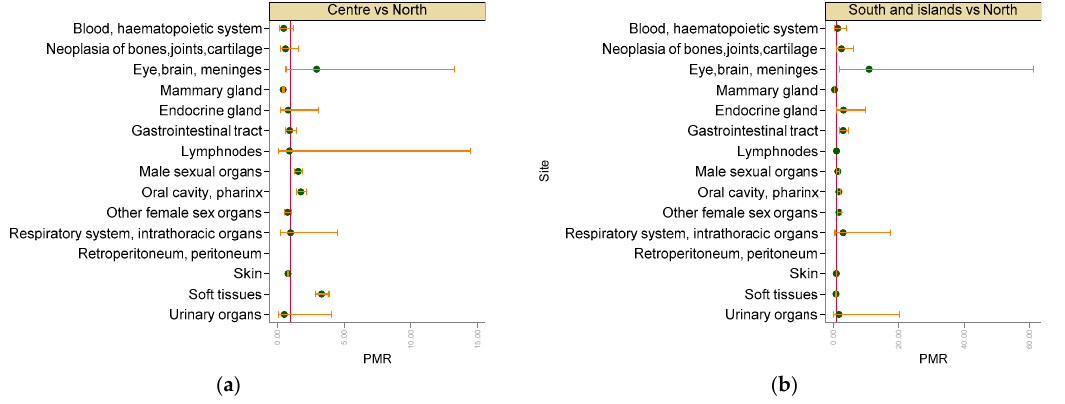
Figure A6. Proportional morbidity ratios of benign tumours by topography comparing benign tumours diagnosed in Centre ( a ) and South and Island ( b ) with Northern Italian regions. Dots: age- class-adjusted PMR, bars: lower and upper bound of 95% confidence interval. A vertical reference line indicates PMR = 1. The PM plotting of benign visceral tumours in different periods and macroregions showed a decrease in PMs in Northern Italy, a clear increase in PMs in Centre Italy and a smaller increase in south and islands (Figure A7). As the trends were not parallel, the effect of time was modified by the macroregion of residence. Figure A7. Proportional morbidity (PM) (solid lines) and their 95% confidence interval (dotted lines) of visceral benign tumours by period and macroregions. References 1.